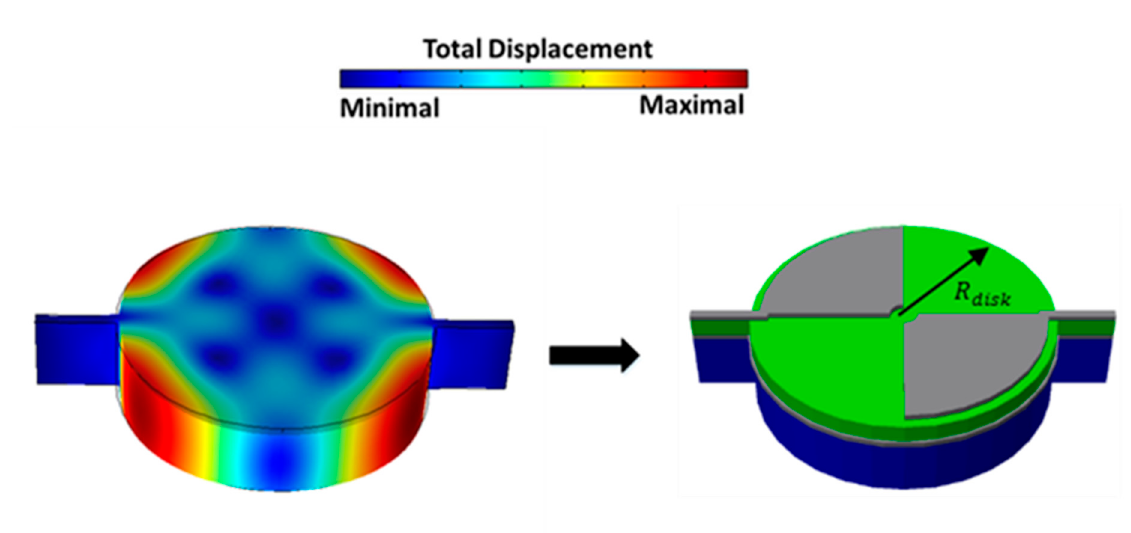
Figure 1. Split top electrode design mapping the resonant mode shape to maximize the output response generated by the ZnO piezoelectric transducer layer for a fourth-order contour resonant